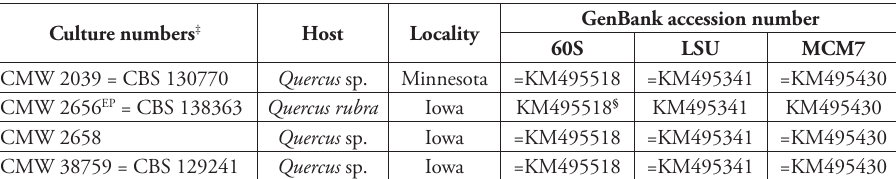
Table 1. Isolates of Bretziella fagacearum † used in this